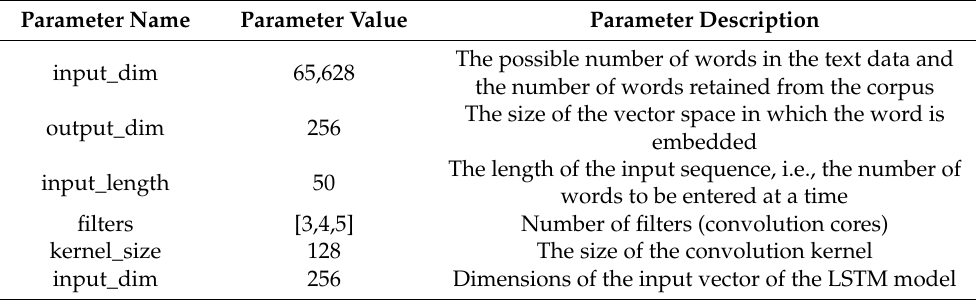
Table 3. Training parameters of the CNN model and the LSTM